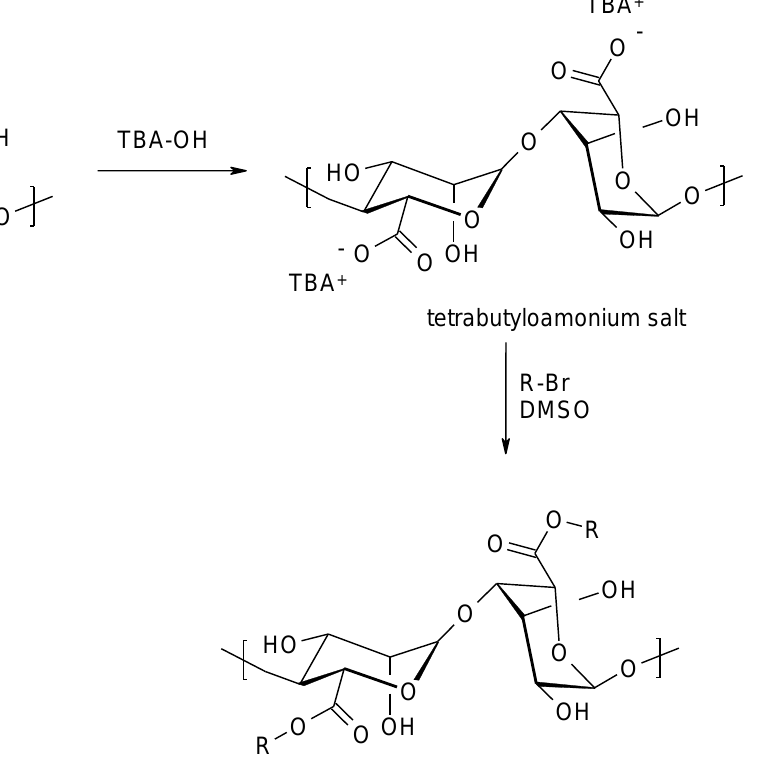
Molecules 2021 , 26 , x FOR PEER REVIEW Figure 16. Synthesis of alginic acid esters using alkyl halides. Figure 16. Synthesis of alginic acid esters using alkyl halides.